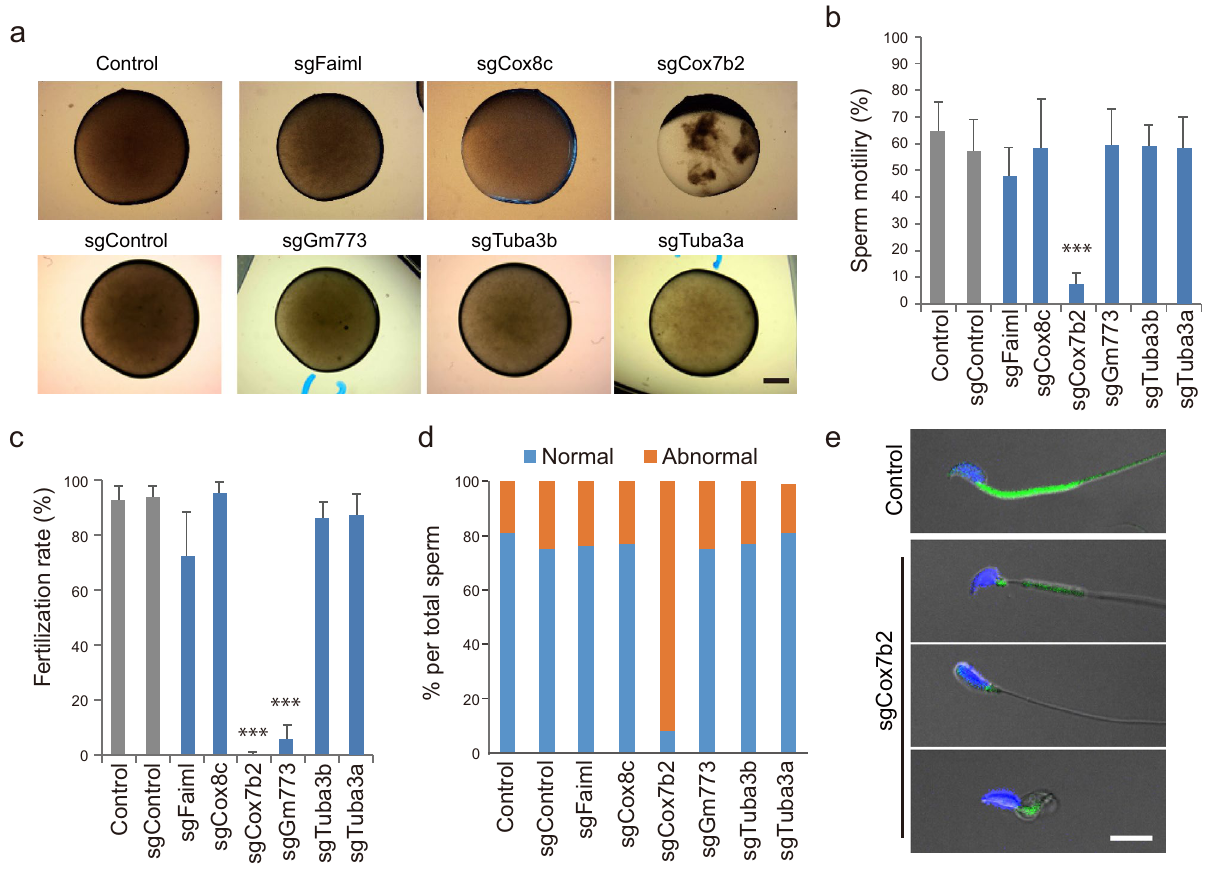
Figure 4. Sperm fertility, motility, and morphology analyses of SRRG KO mice. ( a ) Representative images of HTF drops suspended with epididymis-isolated spermatozoa at 1 h of culture. Scale bar, 1 mm. Note that sperm clots of sgCox7b2 failed to spread throughout the drop and remained aggregated. ( b ) Bar graphs showing the sperm motility examined by CASA at 1 h after preincubation. The motility was severely reduced in sgCox7b2 spermatozoa. *** P < 0.001. See Supplementary Videos S1 and S2 online. ( c ) Bar graphs showing the fertilization rate of spermatozoa of founder males with B6N oocytes by IVF. Fertilized zygotes were